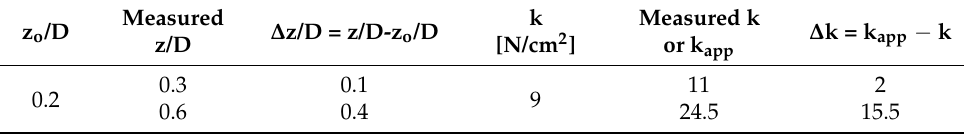
Table 4. The data of the